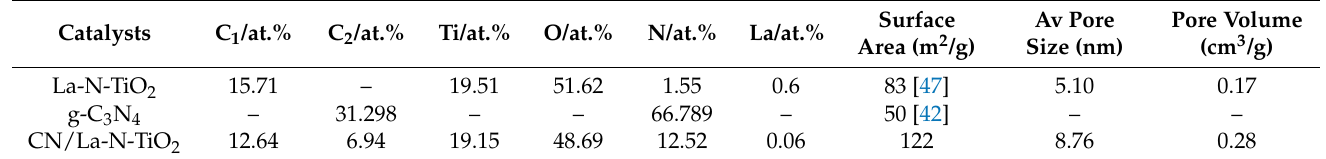
Table 2. Atom concentrations, specific surface area (S BET ), pore size, and band gap of the synthe- sized